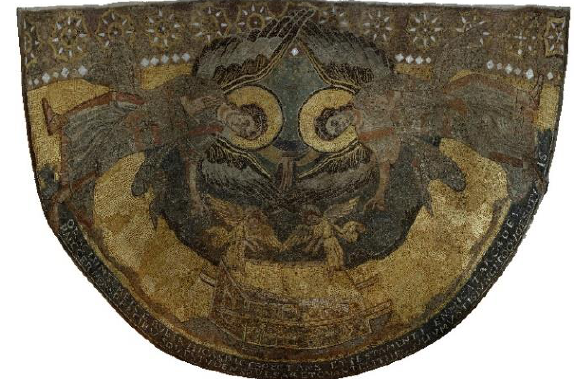
Figure 5. Point clouds, a realistic view from the bottom